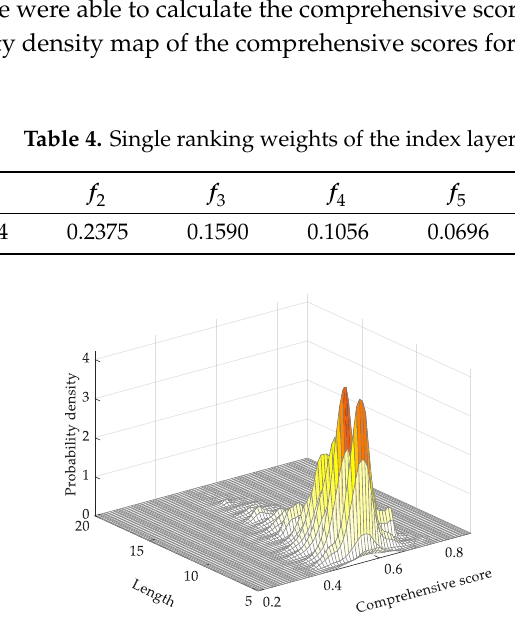
Figure 11. Probability density map of the comprehensive scores for alarm messages.